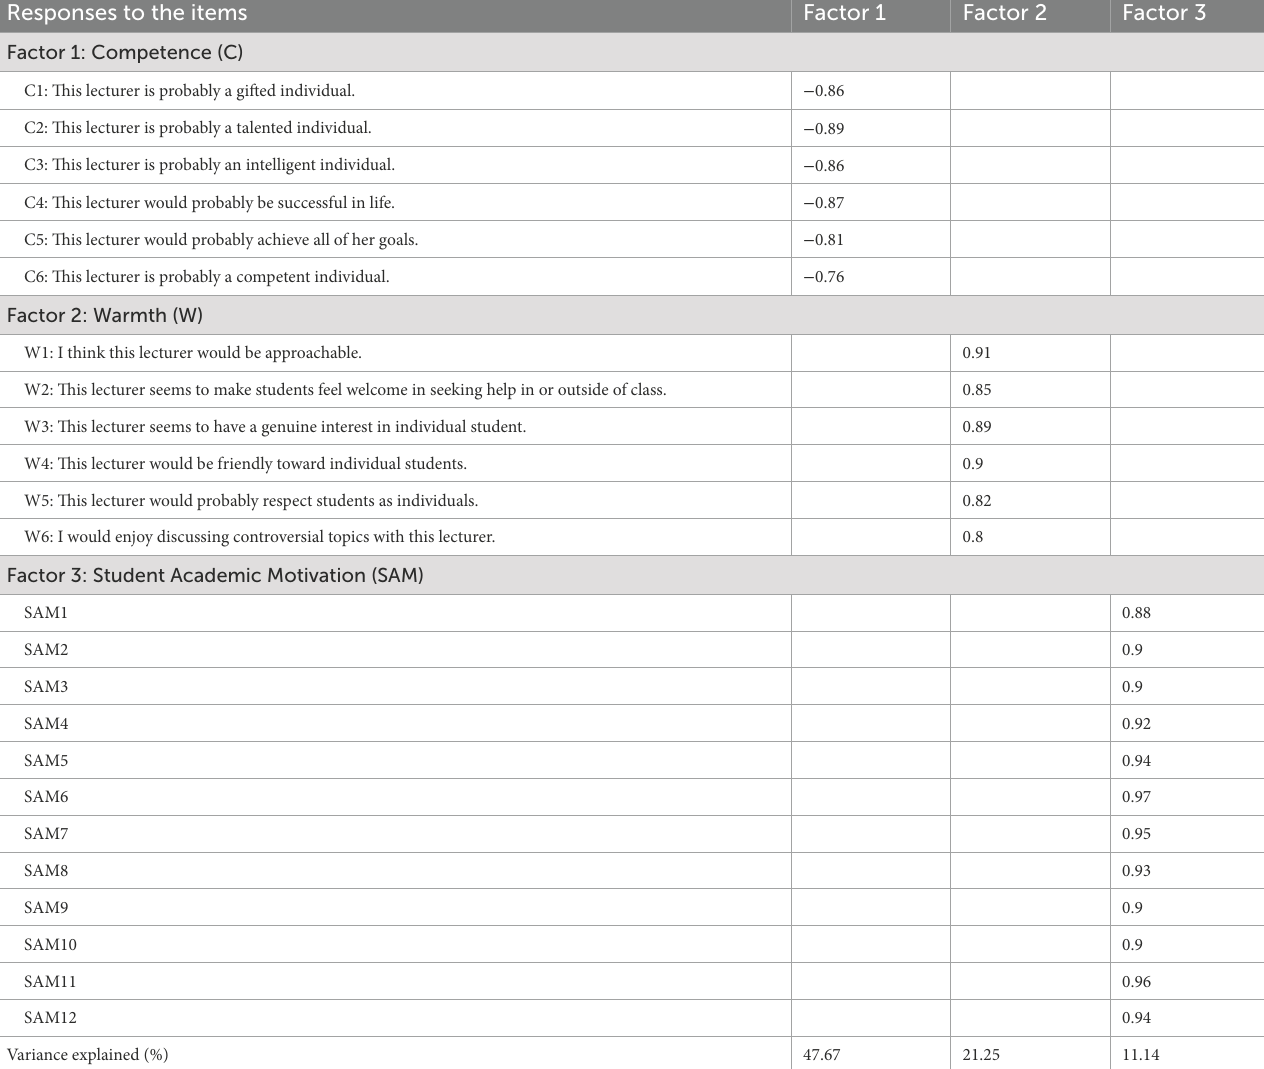
TABLE 1 Factor patters in the responses to the competence, warmth, and student academic motivation measures. Responses to the items Factor 1 Factor 2 Factor